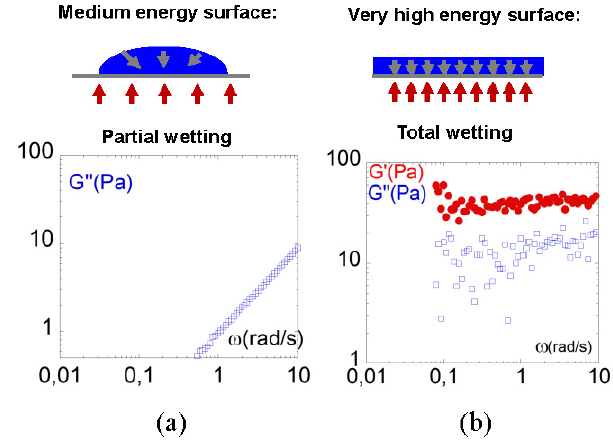
Figure 1. Influence of the wetting on the viscoelastic mesoscopic response of glycerol (from [9]). ( a ) Viscous response obtained on a conventional metallic support (aluminum)—the viscous modulus scales conventionally as G ” = η · ω with η = 1 Pa s. ( b ) Higher viscoelastic moduli are obtained using a wetting substrate (alumina) highlighting a solid-like behavior (G’ > G”) at mesoscopic scale ( e = 40 µm). Room temperature measurements. The upper schemes represent the drop profile in the case of a partial wetting ( a ) and of a total wetting reaching zero contact angle ( b ).